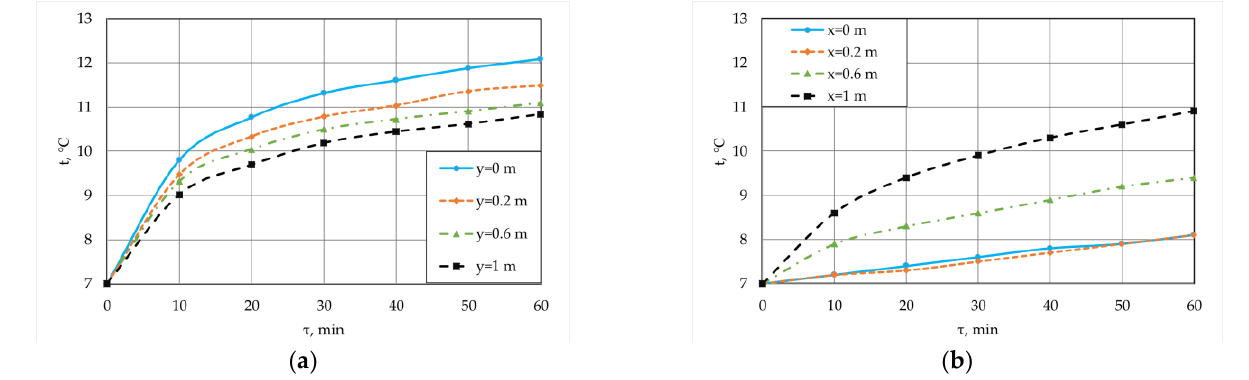
Figure 4. Floor surface temperatures change with increasing time at 0 ≤ X ≤ 1.0 m, Y = 0: ( a ) premises without equipment; ( b ) the panel is located at a height of 0.755 m from the floor.